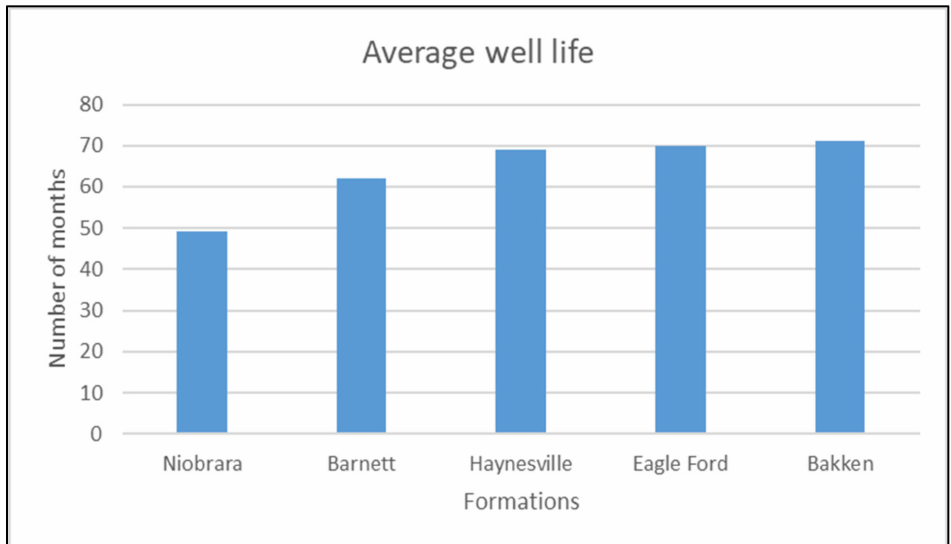
Figure 1. Average well life for each formation.